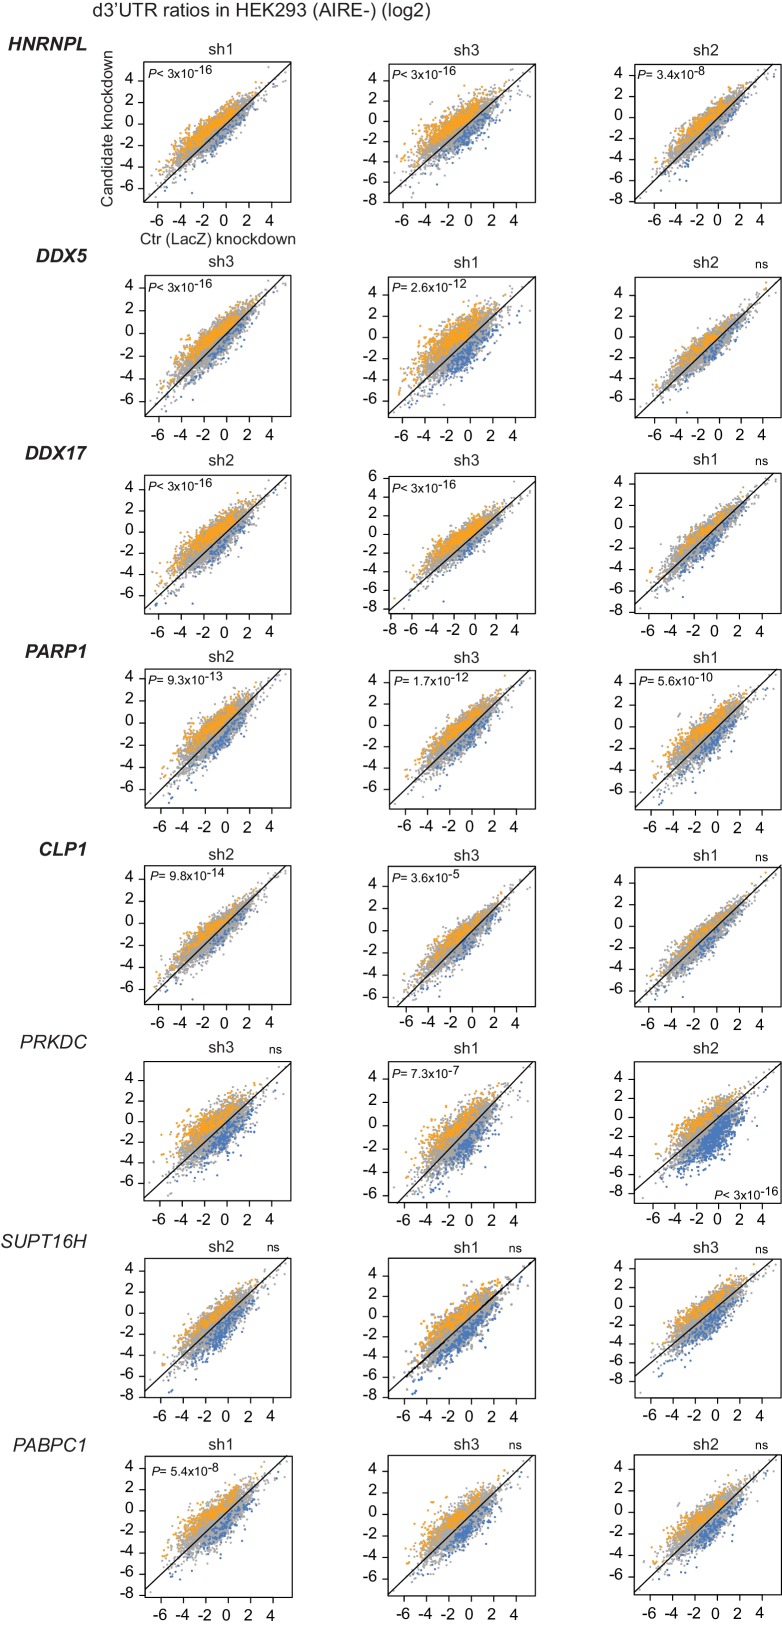
Effect of shRNA-mediated interference of candidate factors on d3’UTR ratios.Individual probe-level analysis of microarray data from HEK293 cells infected by lentiviruses containing one of the three hit shRNAs of each candidate gene or the Ctr (LacZ) shRNA. Genes whose d3’UTR ratios show significant increase or decrease in the candidate vs. Ctr (LacZ) knockdown sample are represented in orange or blue respectively, otherwise in gray. P values comparing the proportion of genes with a significant increase or decrease of d3’UTR ratios to the proportion of genes whose variation is not significant, are assessed by a Chi-squared test and labeled in the quadrant toward which the d3’UTR ratios significantly increase.